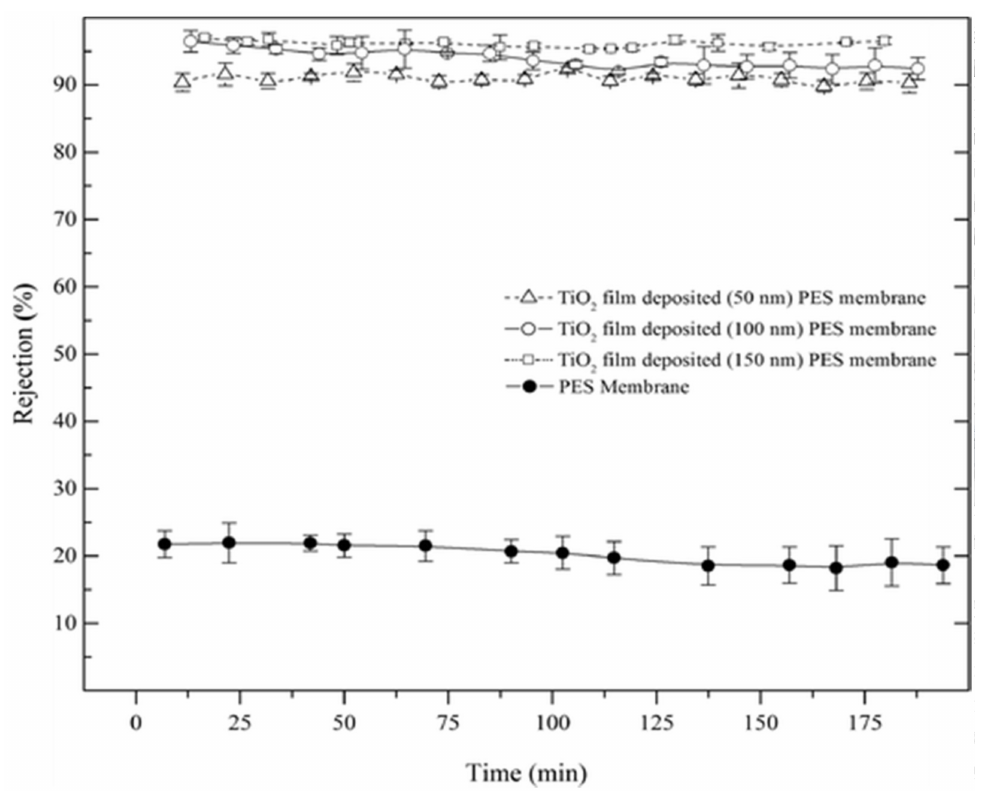
Figure 5. NaCl rejection of the pristine PES substrate membrane and the TiO 2 film deposited—PES membrane. Adapted from